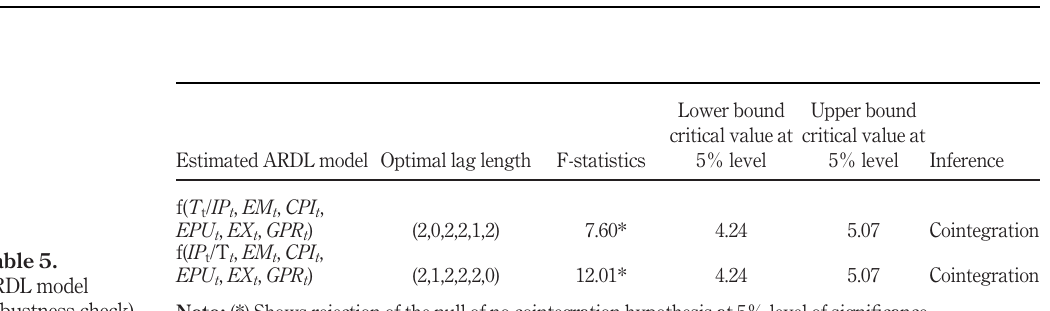
cointegration test